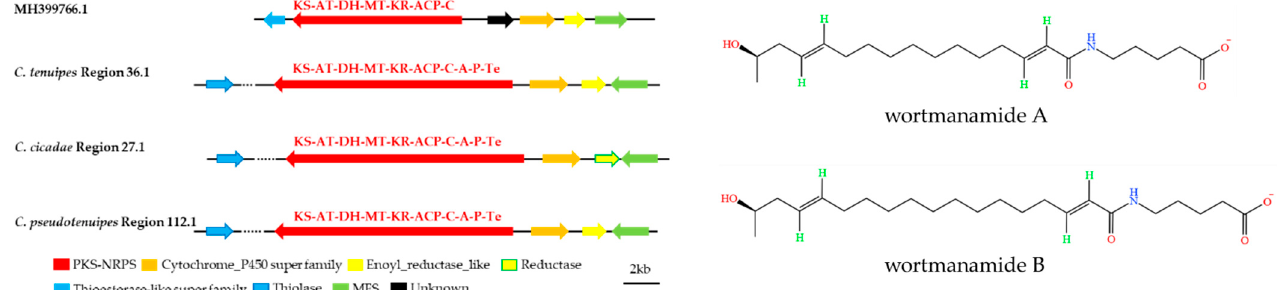
Figure 8. Comparison of putative wortmanamide A or wortmanamide B biosynthetic gene clusters and structure. The number after the region and the number before the decimal point represent the scaffold, and the number after the decimal point represents the gene cluster.